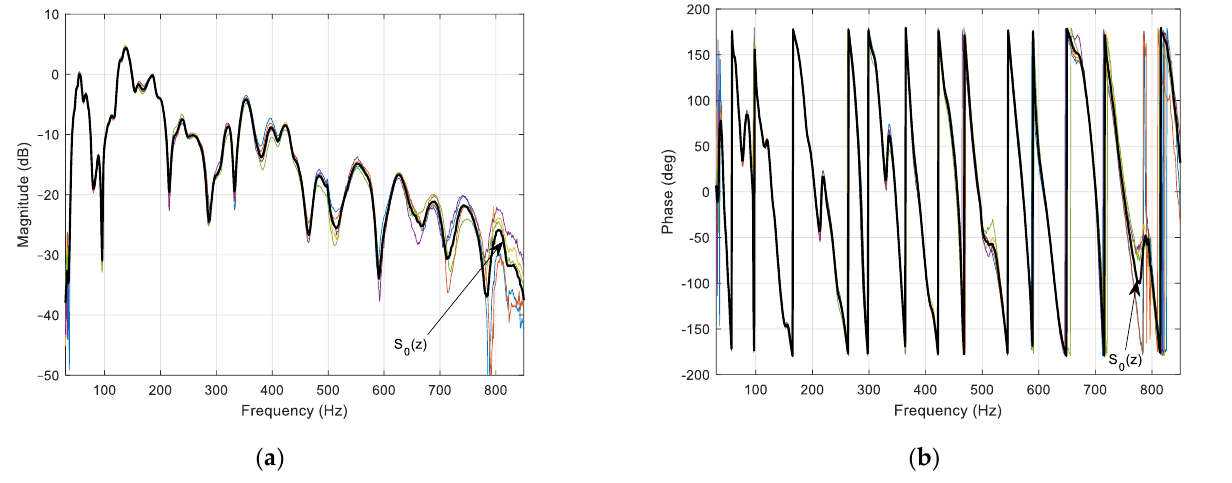
Figure 5. Measured frequency responses of the secondary path using the ESG-cowl pair at five different temperature conditions. ( a ) Magnitude responses. ( b ) Phase responses.